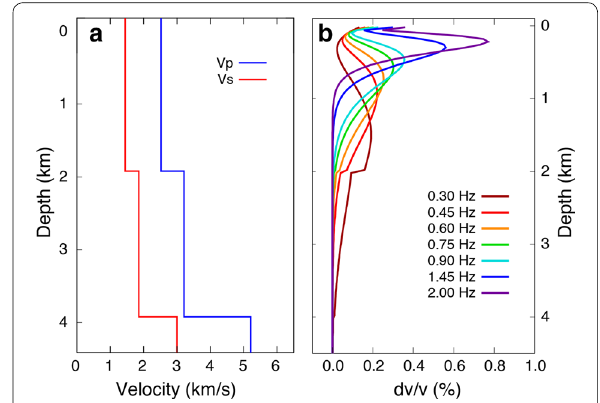
Fig. 4 The 1‑D velocity model and corresponding Rayleigh‑wave depth sensitivity kernels. a The P‑wave (blue) and S‑wave (red) 1‑D velocity models of Kilauea area averaging from the 3‑D velocity model (Lin et al. 2014). b Rayleigh‑wave depth sensitivity kernels for shear wave velocity changes in different frequencies between 0.3 and 2.0